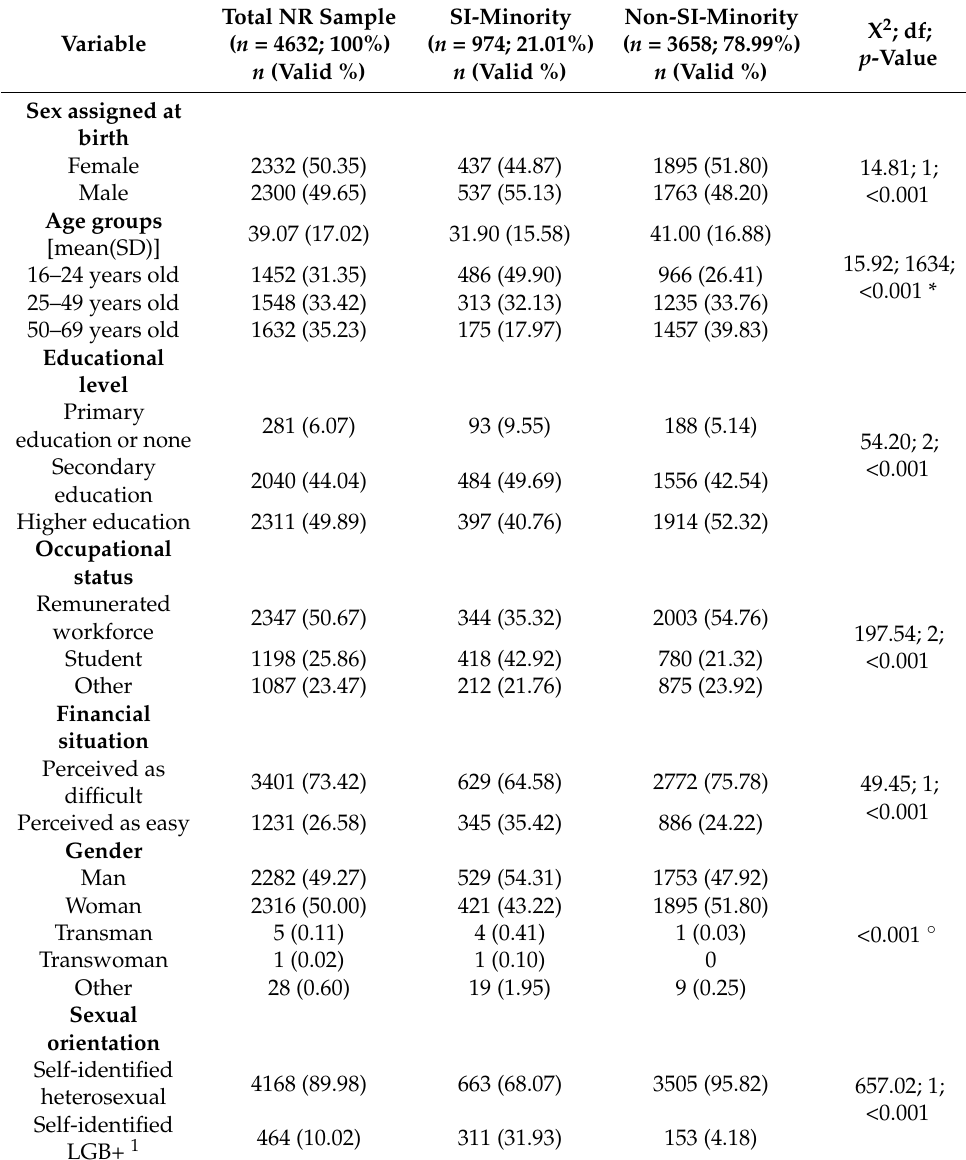
Table 1. Sample composition ( n = 4632; unweighted). Socio-demographic information presented for the total sample and for persons who self-identified as being part of a minority group (SI-Minority) and those who did not self-identify as belonging to a minority group